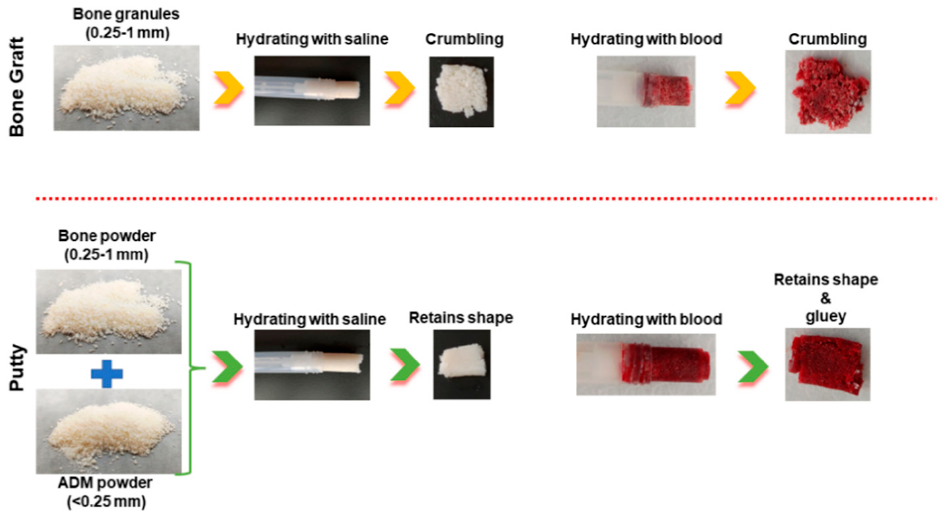
Figure 1. Schematic illustration of the physical nature of the bone graft and putty after hydrating with normal saline and blood.